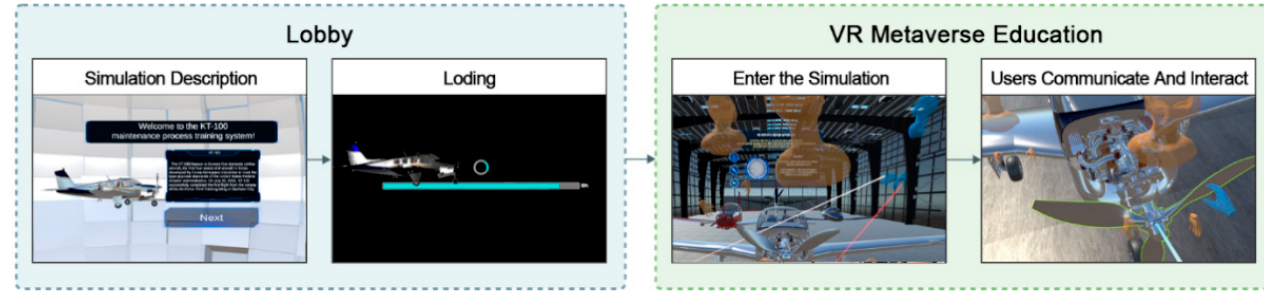
Figure 5. Aircraft maintenance simulation configuration.